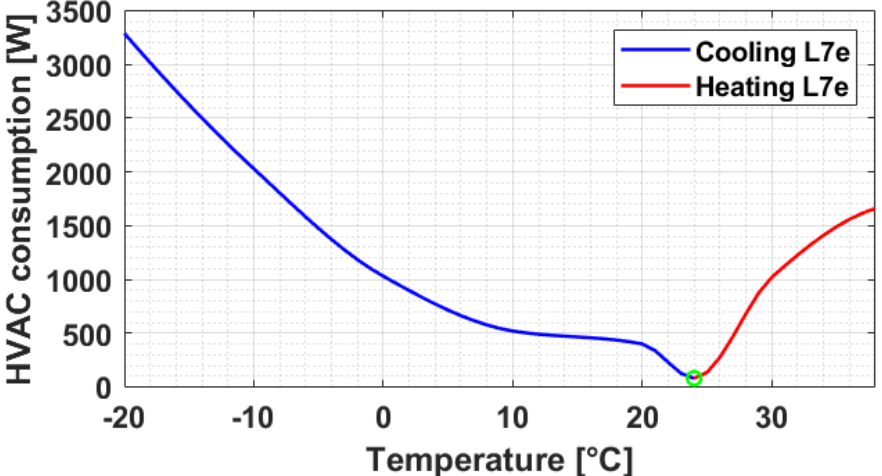
Figure 10. HVAC consumption in cooling and heating